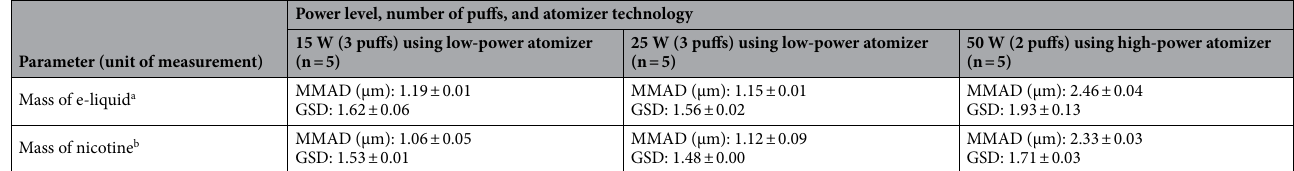
Table 1. Summary of the particle-size distribution data. ± corresponds to the standard deviation of the five experiments for each condition. GSD geometric standard deviation of the mass aerosol distribution, MMAD mass median aerodynamic diameter, µm micrometers. a Calculated using the mass of e-liquid collected on impactor stages. b Calculated using the mass of nicotine collected on impactor stages.